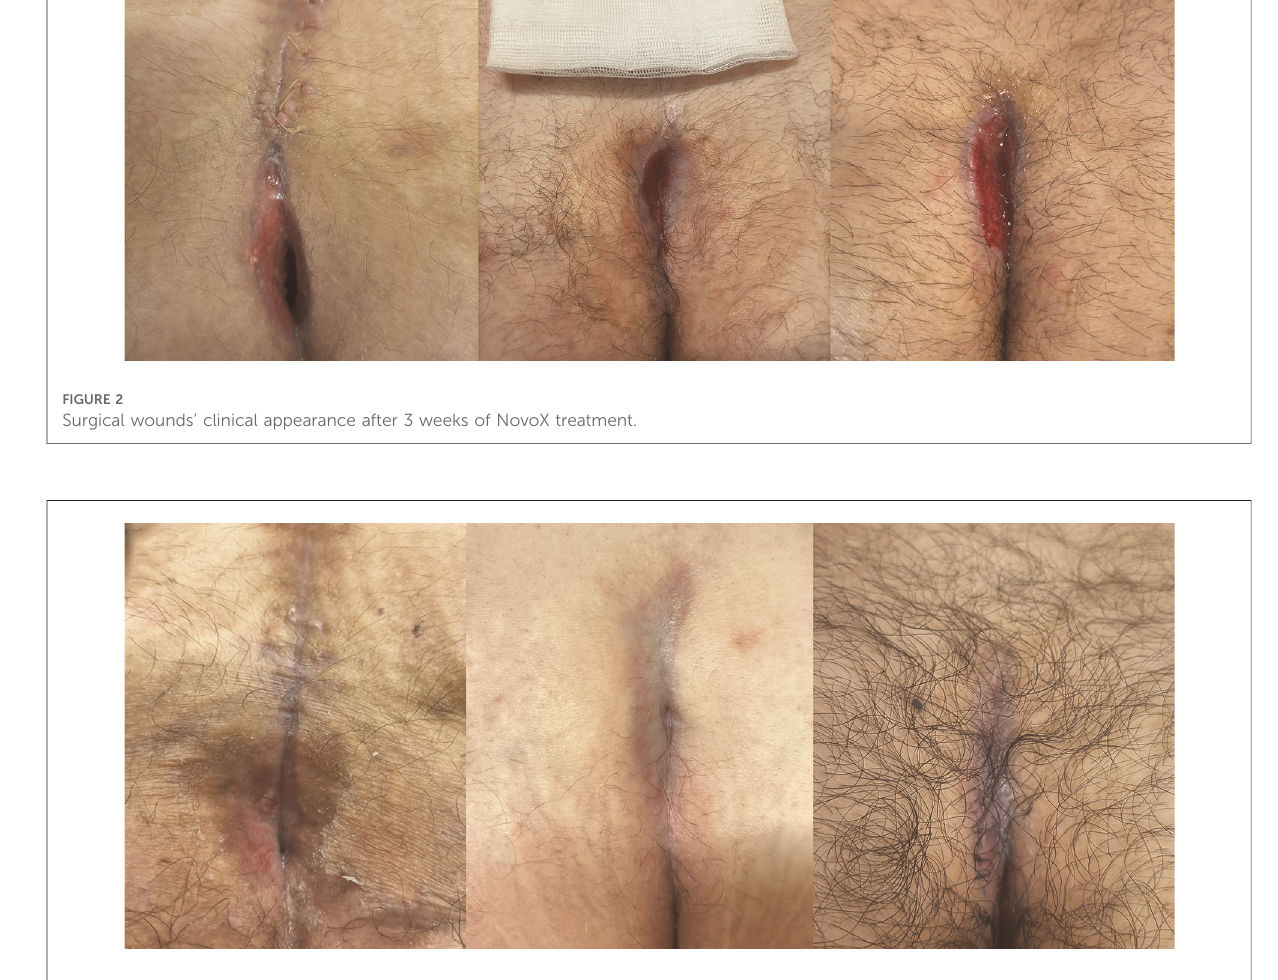
FIGURE 3 Close-up view of the fi nal results at the 3-month